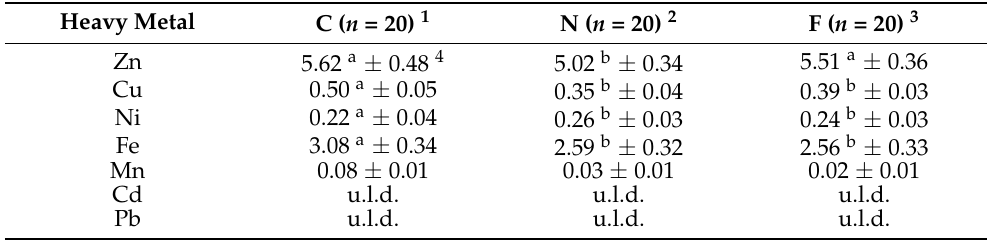
Table 4. The effect of diet on the content of selected heavy metals in rabbit meat (m. longissimus. lumborum) in mg/kg